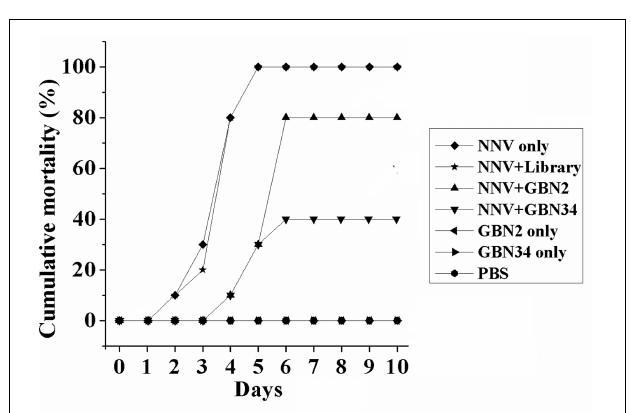
FIGURE 5 | Inhibition of RGNNV infection by aptamers in vivo . Values indicate the cumulative mortality in each group of groupers ( E. coioides ) during the 10-day experimental period after each treatment. The selected aptamers inhibited RGNNV infection in